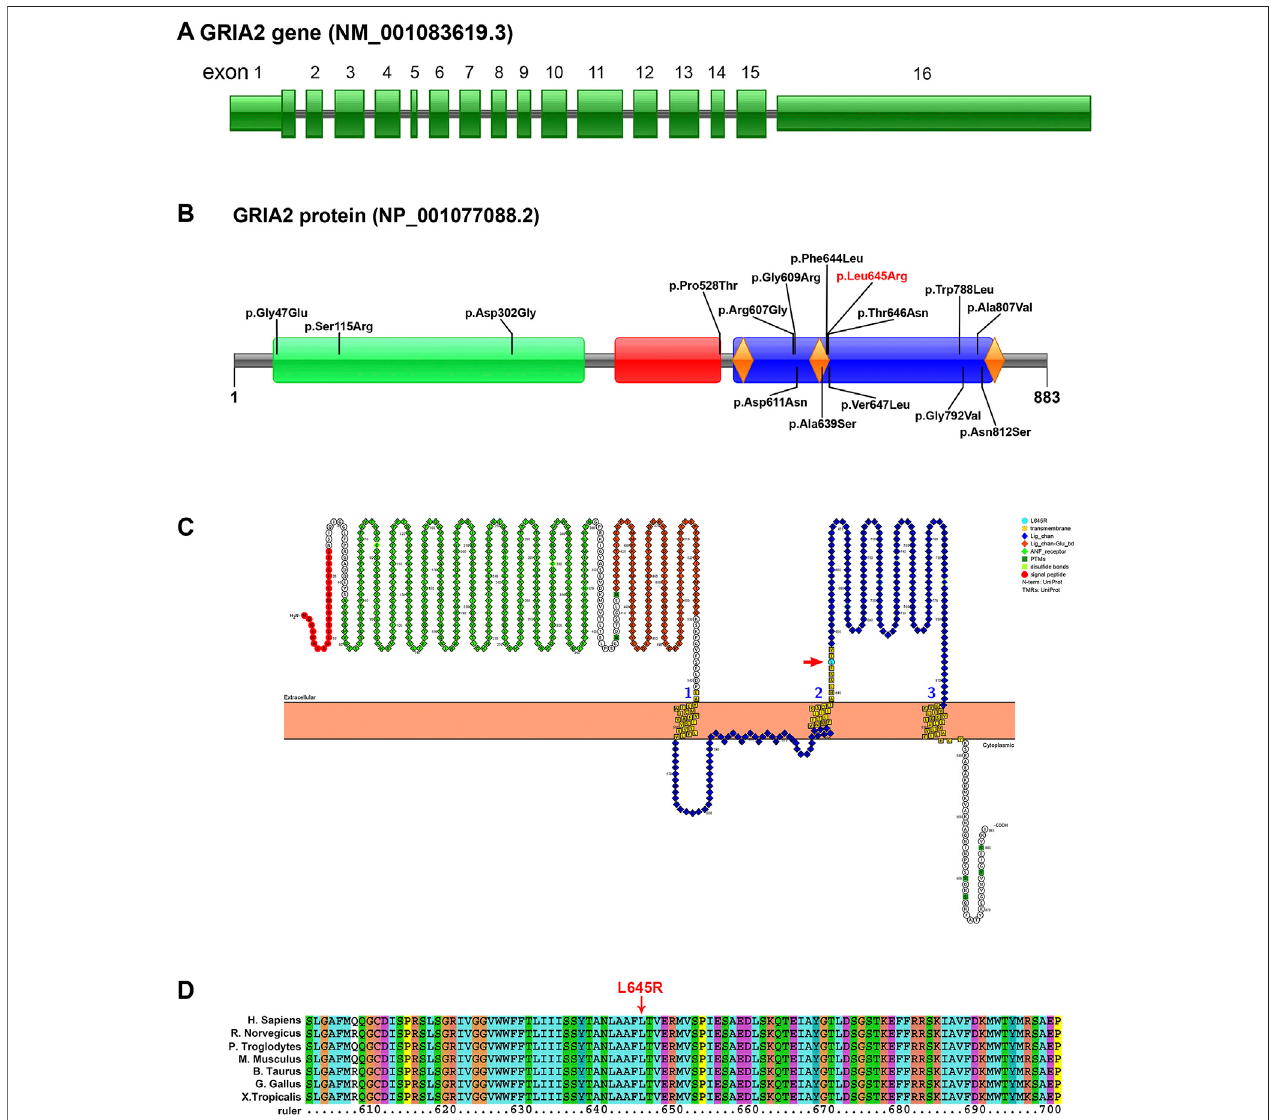
FIGURE2| Patterndiagramofthe GRIA2 genestructure,proteindomain,proteinfunction,andtransmembranedomainandproteinsequenceconservedanalysis. (A) GRIA2 gene (NM_001083619.1) contains 16 exons, and exons 2 – 15 are involved in gene coding. (B) Pattern diagram of the GRIA2 protein domain. It shows the currently reported missense mutation sites thatcause NEDLIB and the sitesin this study(red font). GRIA2 protein mainly has thefollowingthree domains: ANF_recepter (green), Lig_chan-Glu_bd (red), and Lig_chan (blue). The three transmembrane structure regions (orange diamond) are all concentrated on Lig_chan. (C) ANF_recepter and LIG_chan-glu_BD are located outside the cell membrane. Lig_chan had three transmembrane regions. L645R mutation site (red arrow) is in the secondtransmembraneregion. (D) Multiplesequencealignmentof GRIA2 proteinsfrom7speciesshowsthattheL645Rmutationsiteiswithintheconservedsequence. Human ( Homo sapiens , NP_001077088.2), Norway rat ( Rattus norvegicus , NP_001077280.1), chimpanzee ( Pan troglodytes , NP_001171923.2), house mouse ( Mus musculus , NP_001077275.2), cattle ( Bos taurus , NP_001069789.2), chicken ( Gallus gallus , NP_001001775.2), and tropical clawed frog ( Xenopus tropicalis ,